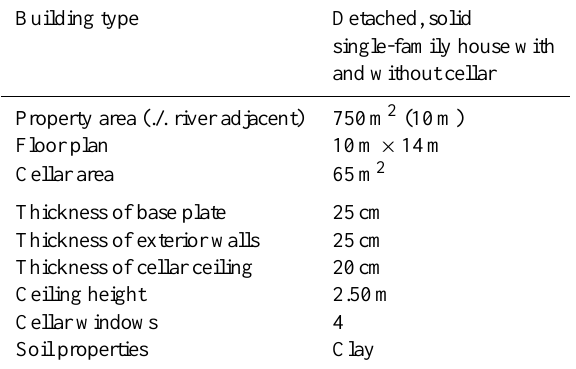
Table 2. Model building for